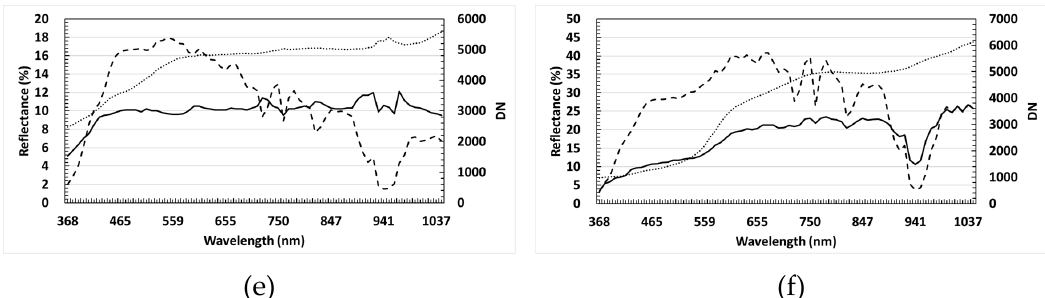
Figure 5. The comparison of the spectra measured at 15 sites outside TNP (dotted lines), the spectra extracted from the CASI imagery (broken lines), and the FLAASH-corrected imagery (solid lines). The cases of ( a ) site 1: asphalt, ( b ) site 6: asphalt, ( c ) site 7: floor tiles, ( d ) site 12: cement, ( e ) site 10: sand, and ( f ) site 9: red soil.